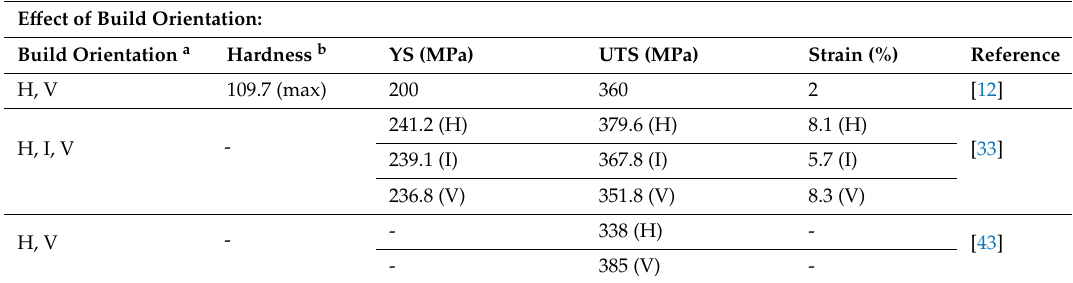
Table 4. Mechanical properties of SLM-printed AlSi 10